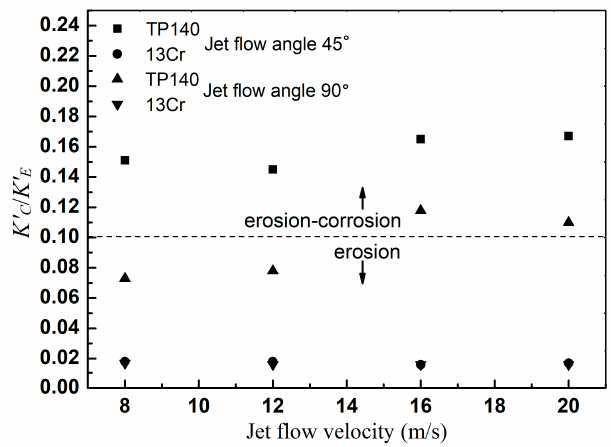
Figure 9. Map of dominant factors for TP140 and 13Cr.